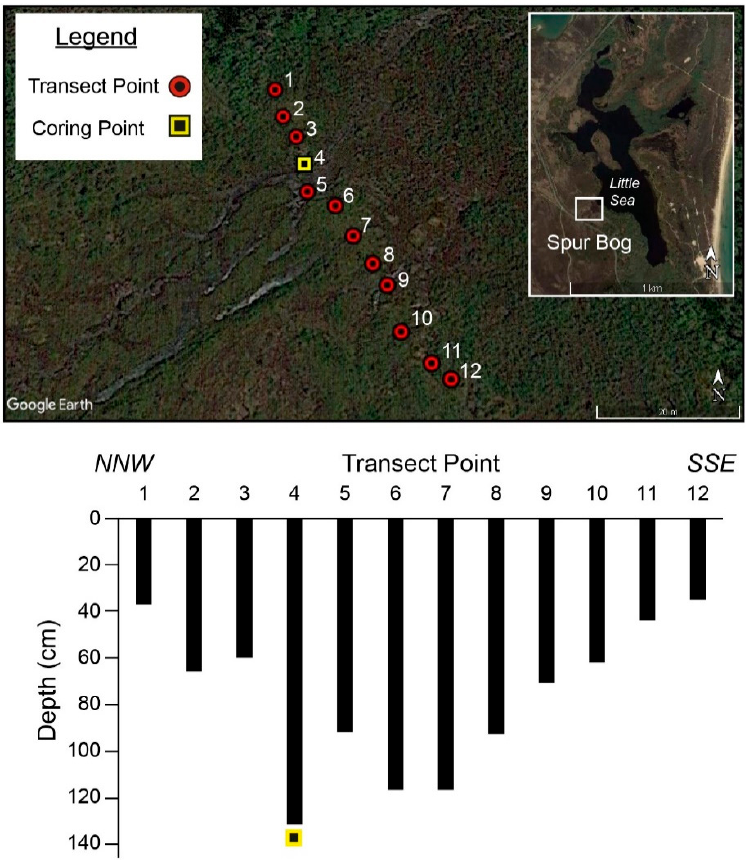
Figure 4. Location map of the NNW–SSE transect and sampling points of Spur Bog. The composite core SPUR-A has been taken from transect point 4 (yellow square).